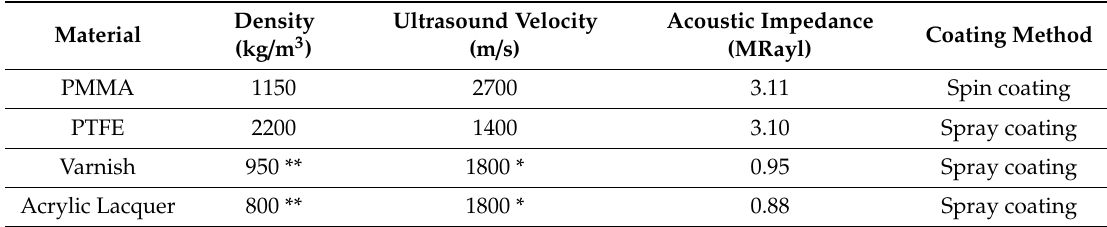
Table 2. Coating material properties and method employed.